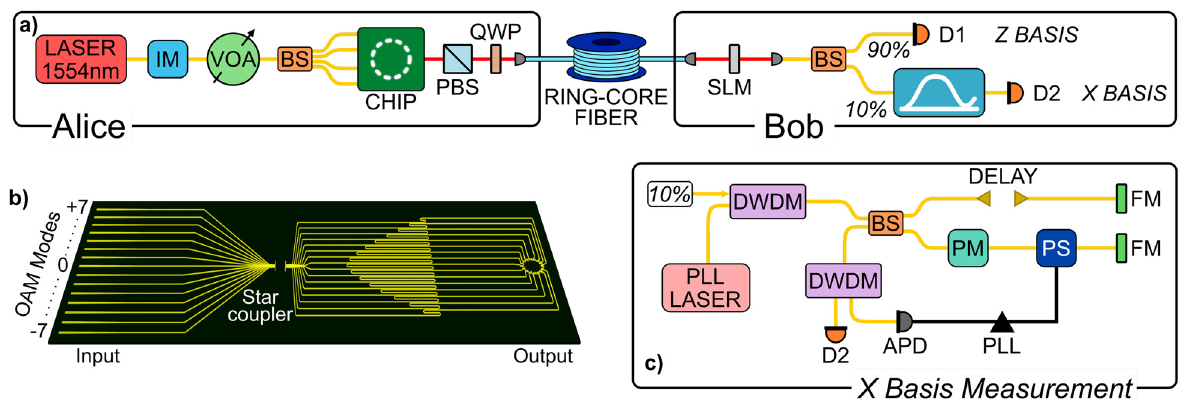
Figure 1: Realization of OAM multiplexing, time-bin encoding quantum key distribution. (a) Experimental setup. IM: intensity modulator; VOA: variable optical attenuator; BS: beam-splitter; PBS: polarization beam-splitter; QWP: quarter-wave plate; SLM: spatial light modulator; D i : i th detector. (b) Schematic of the photonic integrated device. (c) X basis measurement setup. PLL: phase-locked loop; DWDM: dense wavelength-division-multiplexing; PM: phase modulator; PS: phase shifter; FM: Faraday mirror; APD: avalanche photodiode; PLL: phase-locked loop.